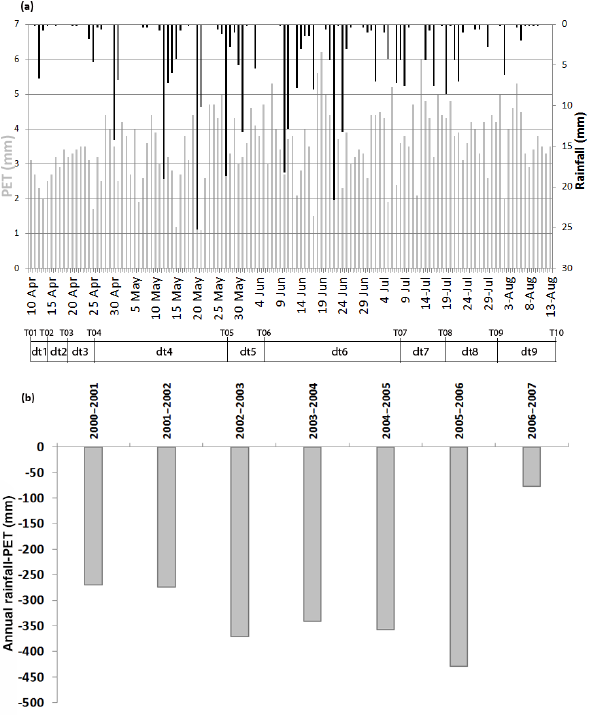
Figure 2. (a) Daily rainfall and potential evapotranspiration (PET) measured during the monitoring period (10 April to 13 Au- gust 2007). ERT measurement dates (T01 to T10) and intervals be- tween them (dt1 to dt10) are indicated along the x axis. (b) Annual net rainfall (rainfall − PET) calculated for the previous 6 years. An- nual net rainfall calculated for each interval of the monitoring period and compared to that of the previous 6 years is presented in Fig.